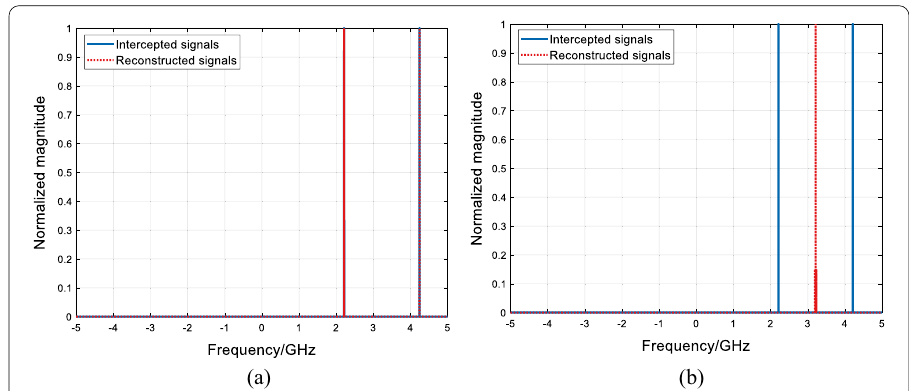
Fig. 3 Spectra of intercepted mono-pulse signals and reconstructed signals using SFM LO. a First group, b Second